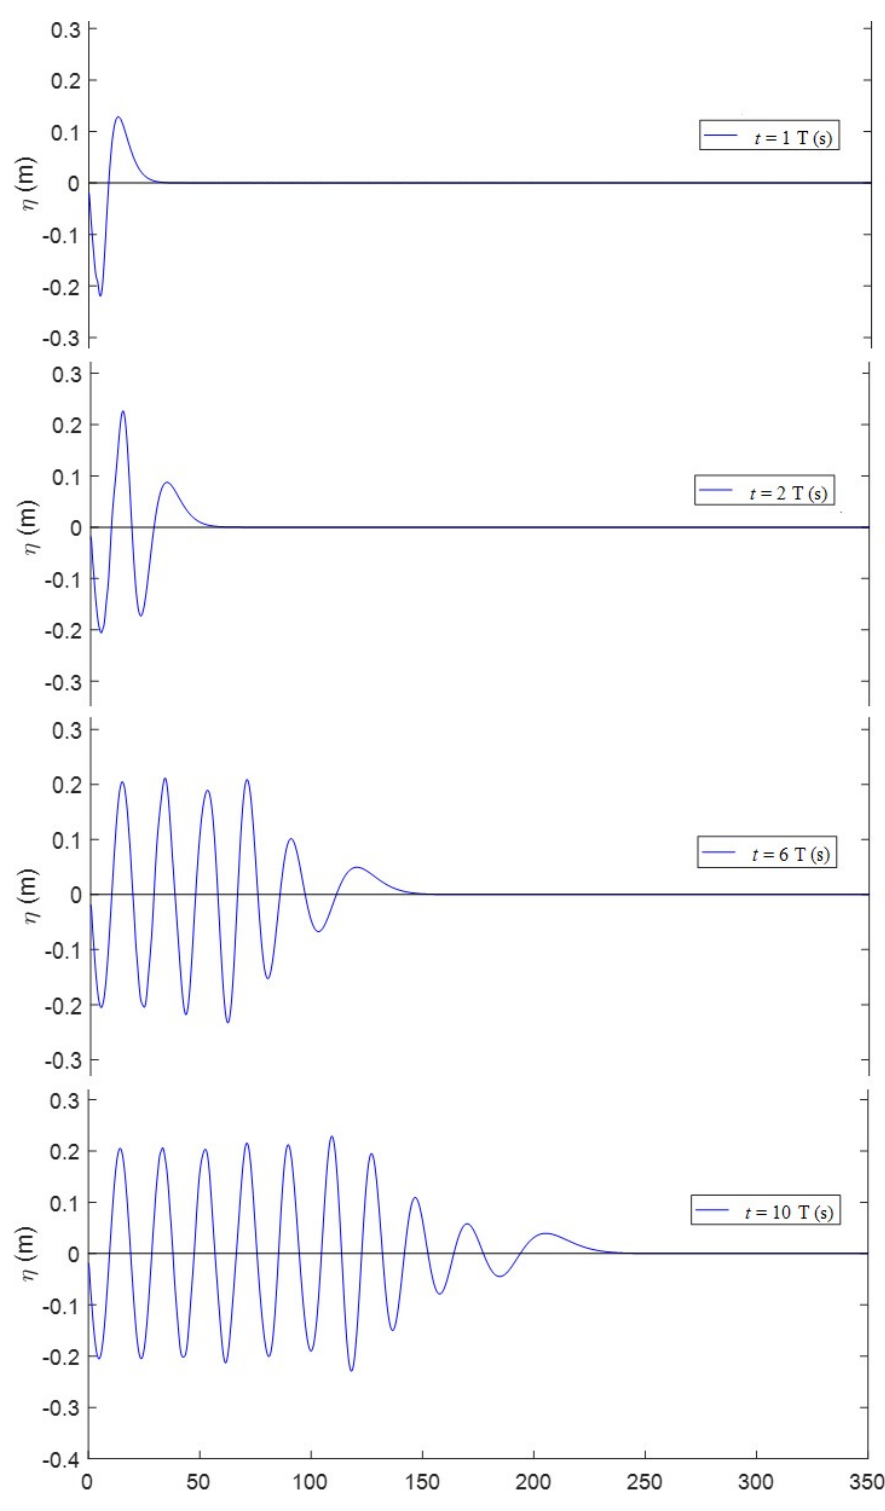
Figure 8. Generated waves along the wave channel for one, two, six, and 10 periods.